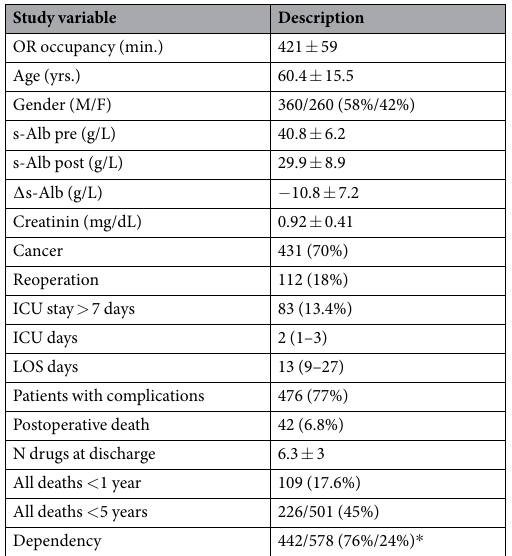
Table 1. Demographic, clinical and outcome characteristics of the study cohort (N = 620). * Postoperative deaths excluded.